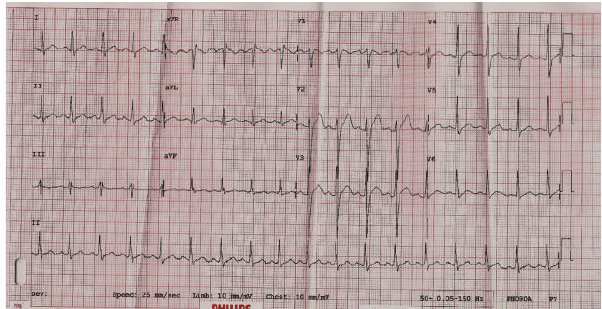
Figure 1: 12-lead electrocardiogram showing sinus rhythm with left ventricular hypertrophy and no significant acute ischemic changes in a patient with ascending aortic dissection.